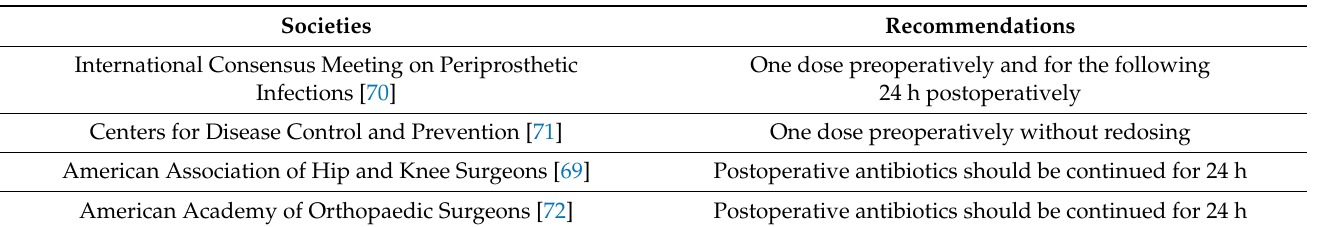
Table 3. Recommendations for perioperative use of antibiotics in conventional total joint